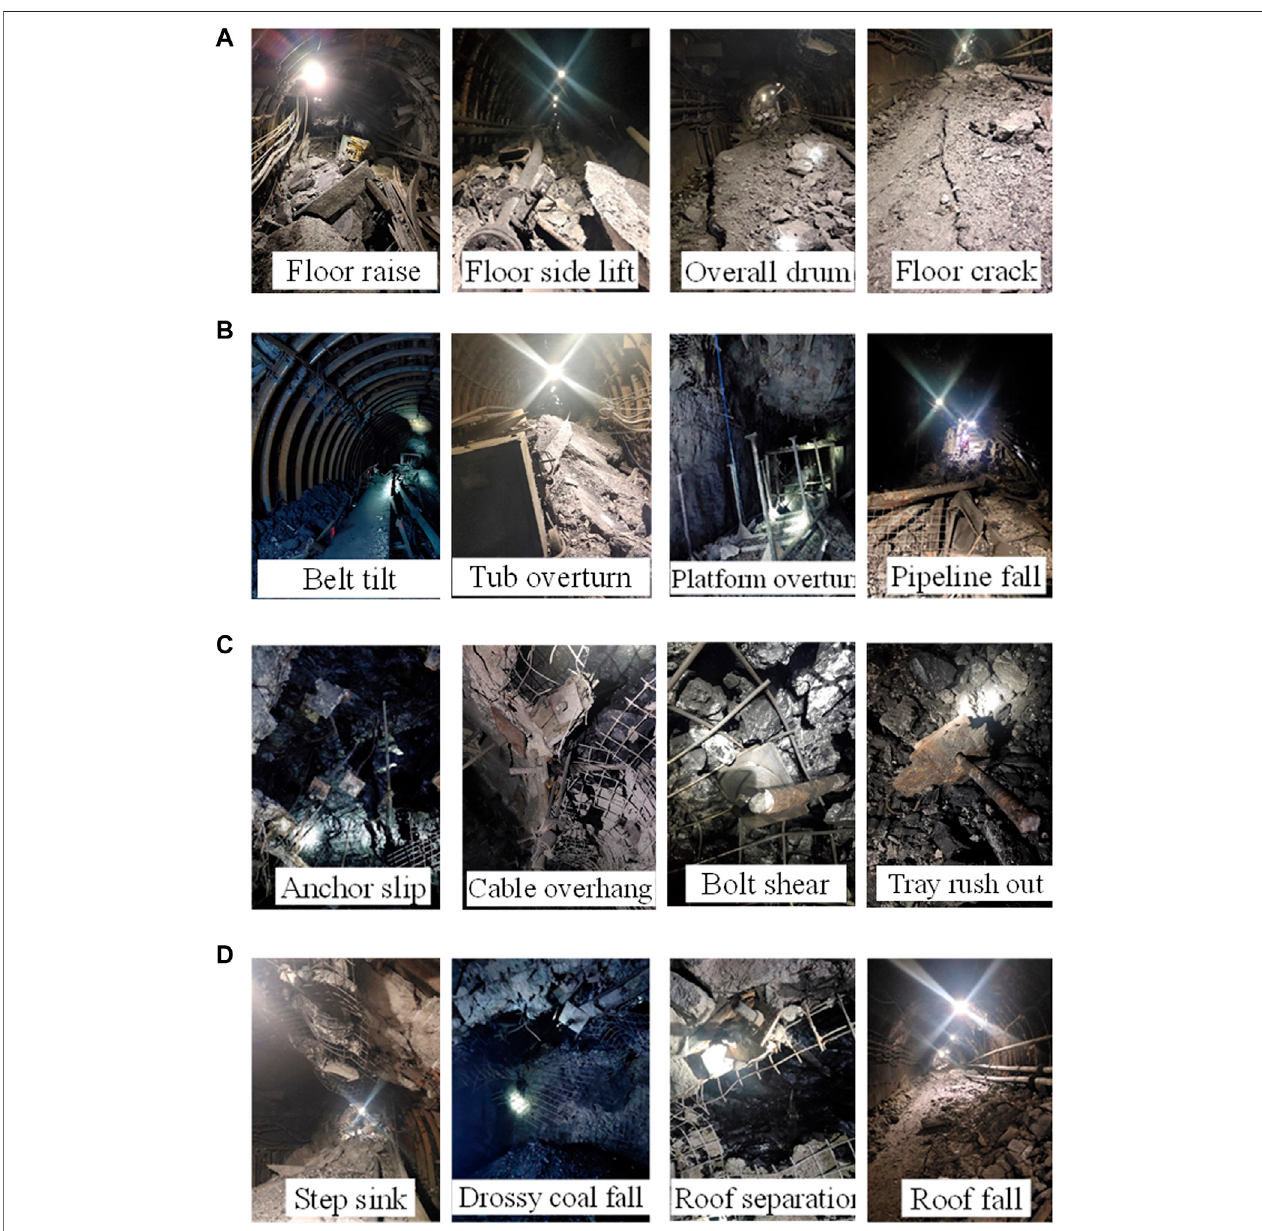
FIGURE 5 | Pictures of burst failure of coal burst on site. (A) Floor bulge; (B) Equipment damage; (C) Support failure; (D) Roof caving.